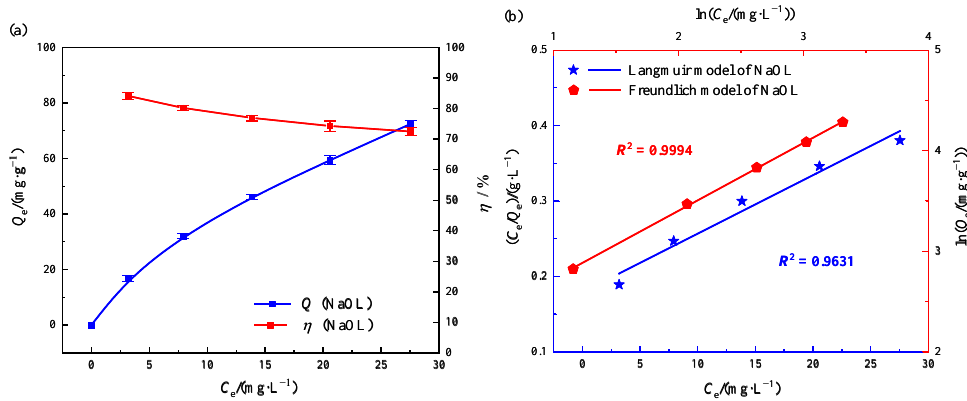
Figure 5 and Table 4. Under low initial concentration ( C 0 ≤ 100 mg · L − 1 ) conditions, the Q e